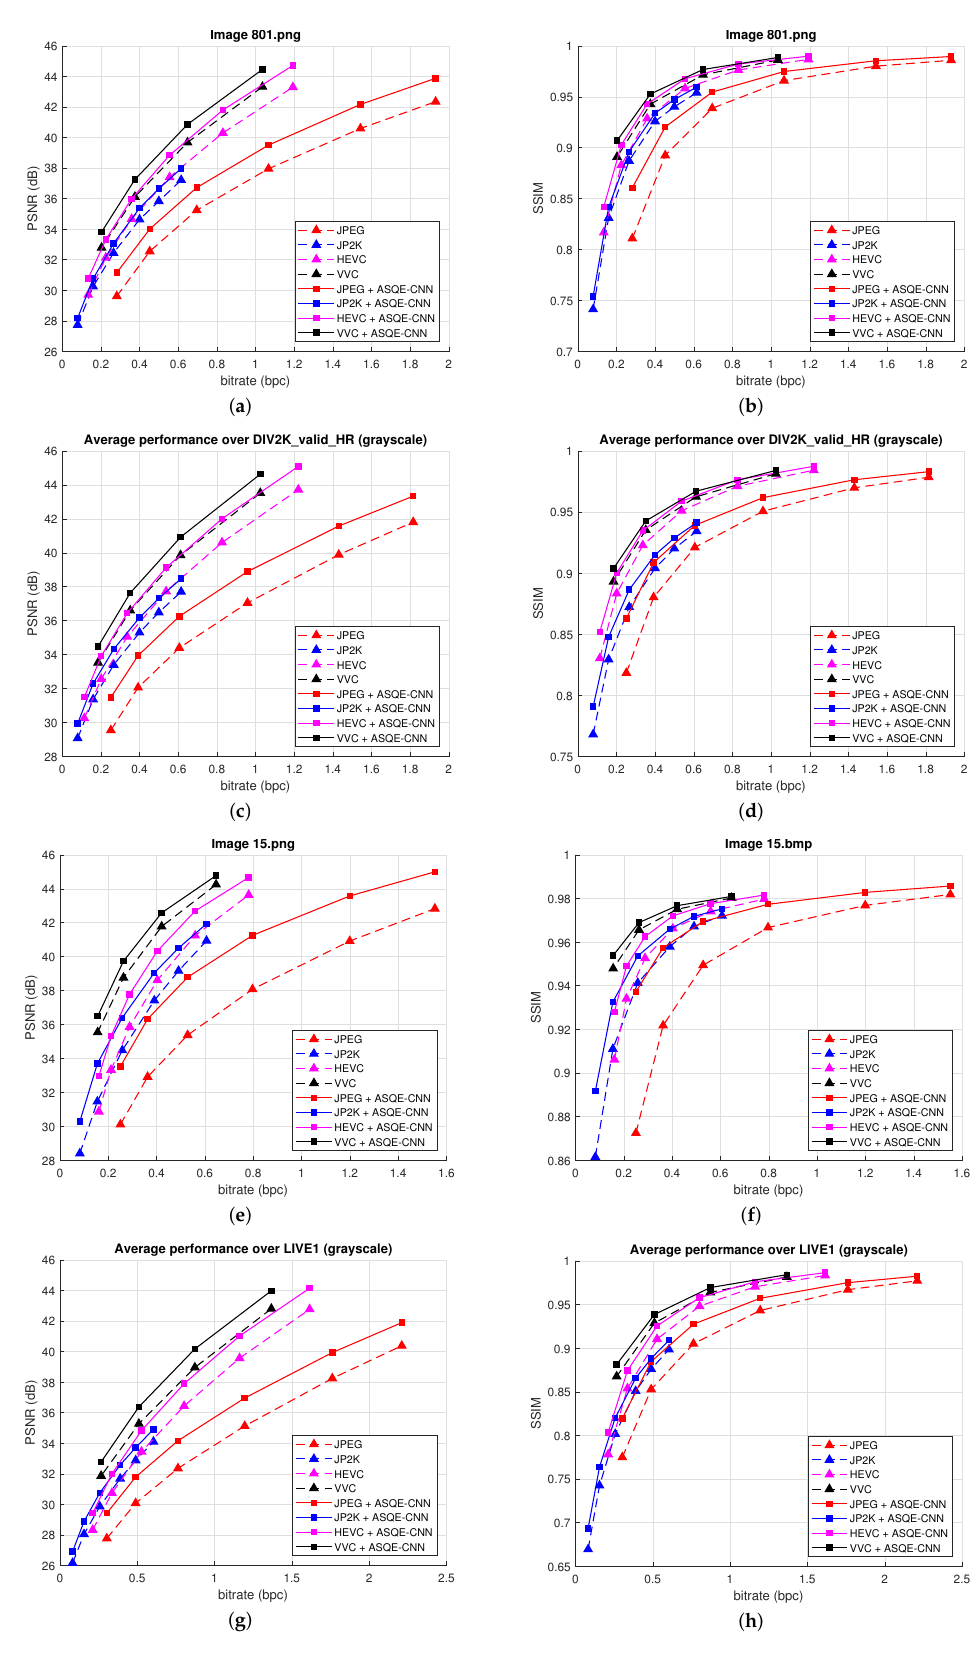
Figure 9. Rate-distortion results: ( a , b ) for Image 801.png from DIV2K_valid_HR [52], ( c , d ) over DIV2K_valid_HR [52] dataset, ( e , f ) for Image 15.bmp from LIVE1 [54], ( g , h ) over LIVE1 [54] dataset. ( Left ) bpc vs. PSNR results. ( Right ) bpc vs. SSIM